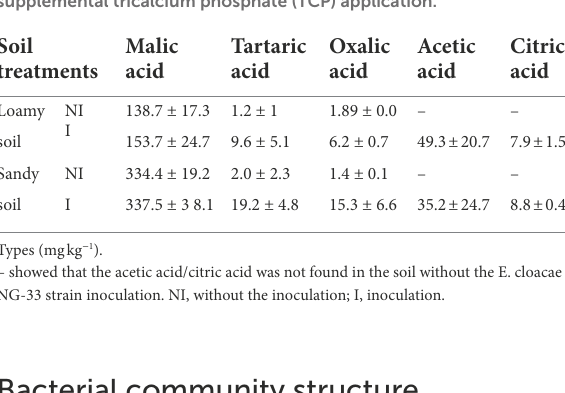
TABLE 2 Effect of Enterobacter cloacae NG-33 strain inoculation on organic acid composition under loamy and sandy soil with supplemental tricalcium phosphate (TCP)